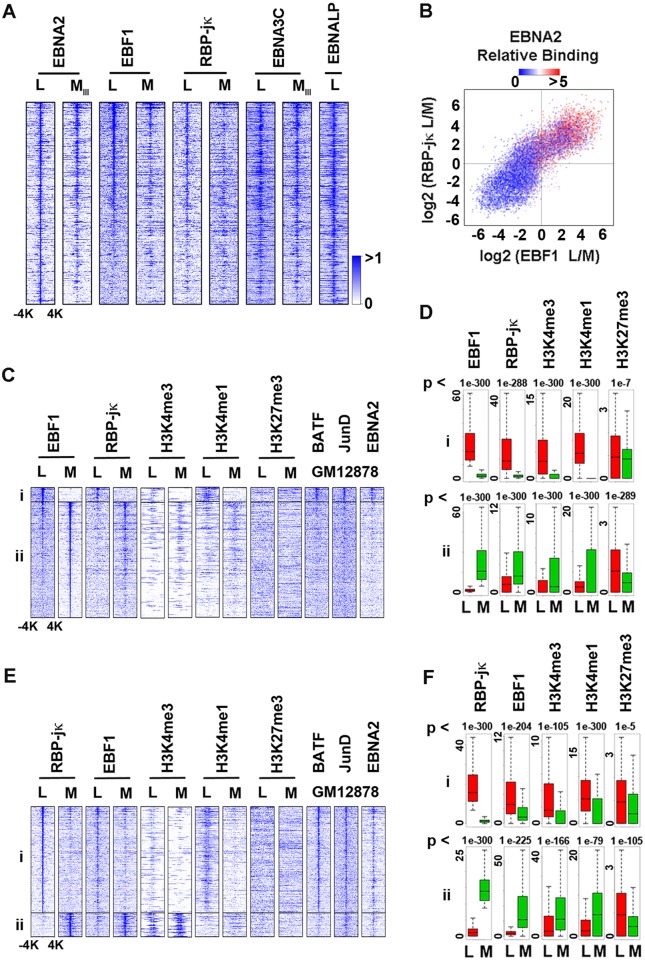
Colocalization of EBNA2 with RBP-jκ and EBF1 co-occupied sites.
(A) Heatmap of EBNA2 ChIP-Seq peaks from LCL was compared with EBNA2 peaks from Mutu III, EBF1 and RBP-jκ from LCL or Mutu I, EBNA3C from LCL or Mutu III, or EBNALP from LCL. Peaks were sorted based on the EBNA2 levels in LCL and show -/+ 4kb window. (B) The fold changes (LCL versus Mutu I) were plotted for EBF1 (x-axis) and RBP-jκ (y-axis) for all EBF1 and RBP-jκ peaks. The peaks were colored based on the EBNA2 occupancy. The positive correlation (Pearson’s correlation coefficient = 0.8) between the fold changes suggests that EBF1 and RBP-jκ co-localize with each other. The strong occupancy of EBNA2 at the top-right panel of the plot shows that high occupancy EBNA2 correlates with sites of high occupancies for EBF1 and RBP-jκ. (C) Heatmap comparison of histone modification marks (H3K4me3, H3Km4me1, H3K27me3) and transcription factors BATF, JunD, and EBNA2 from LCL centered at EBF1 peaks enriched in LCL (cluster i) or Mutu I (cluster ii). (D) Box plot quantitation of peak number and intensity for ChIP-Seq clustered sets i and ii shown in panel C as indicated. (E and F) Same as in C and D, except centered at cell-specific RBP-jκ peaks.